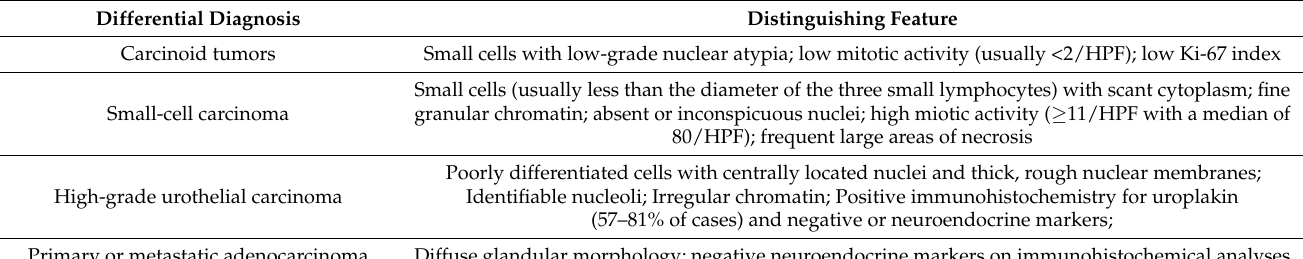
Table 8. Differential diagnosis of large-cell ureteral NEC